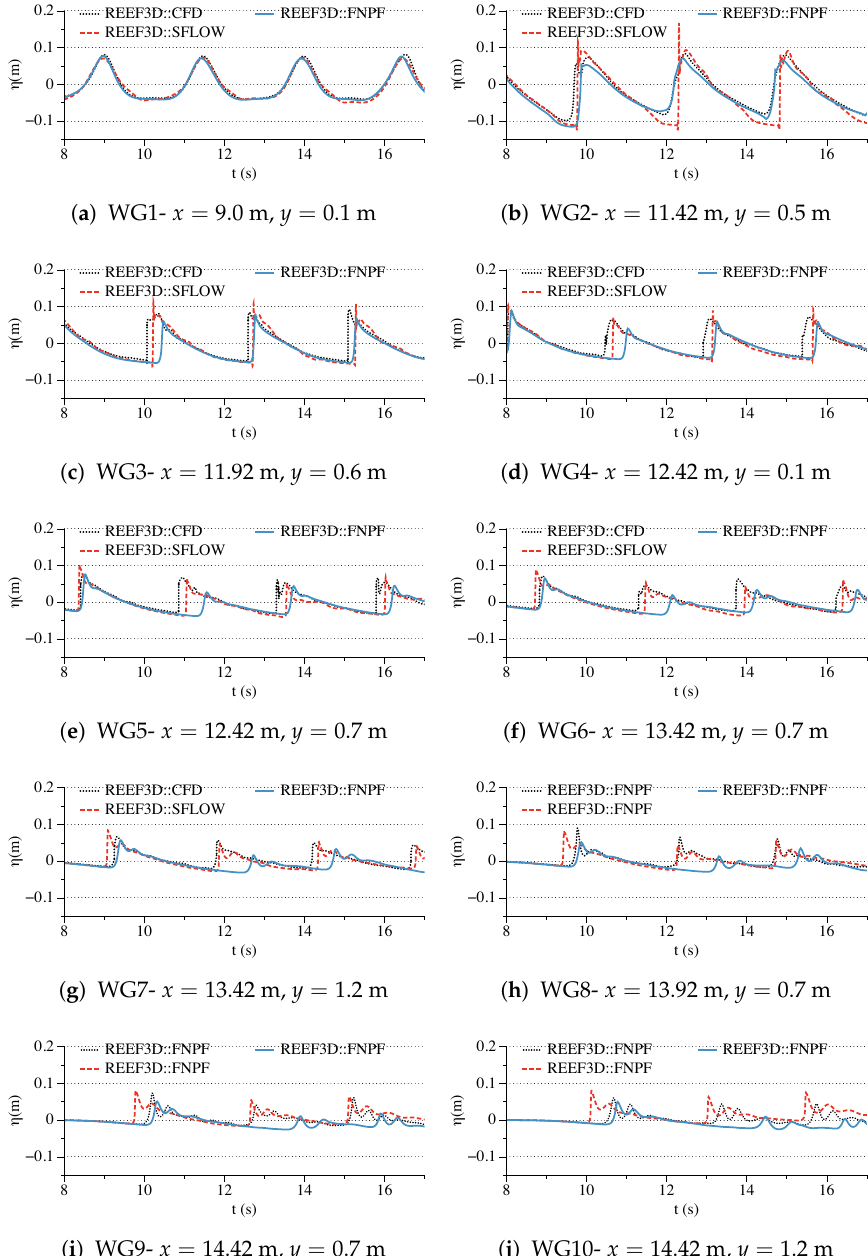
Figure 10. Free surface elevations at several locations in the numerical wave tank for three-dimensional wave breaking on a submerged reef calculated using CFD and